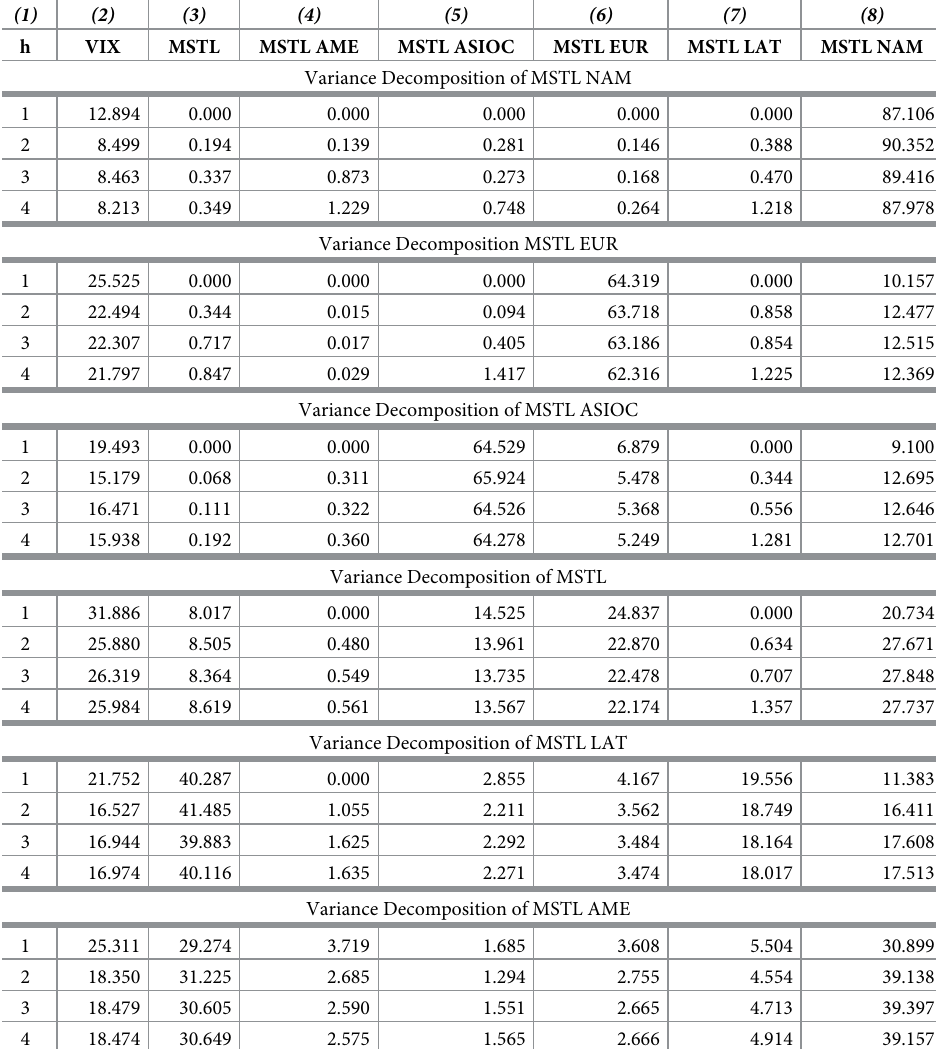
Table 9. Forecast error variance decomposition results for the period from 2001 to